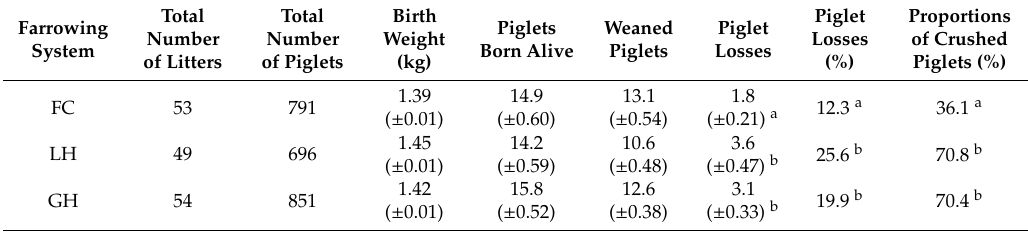
Table 1. Mean values and standard error of the mean for piglets born alive per litter, weaned piglets per litter and piglet losses per litter. FC = pens with farrowing crate, LH = single loose housing pens, the